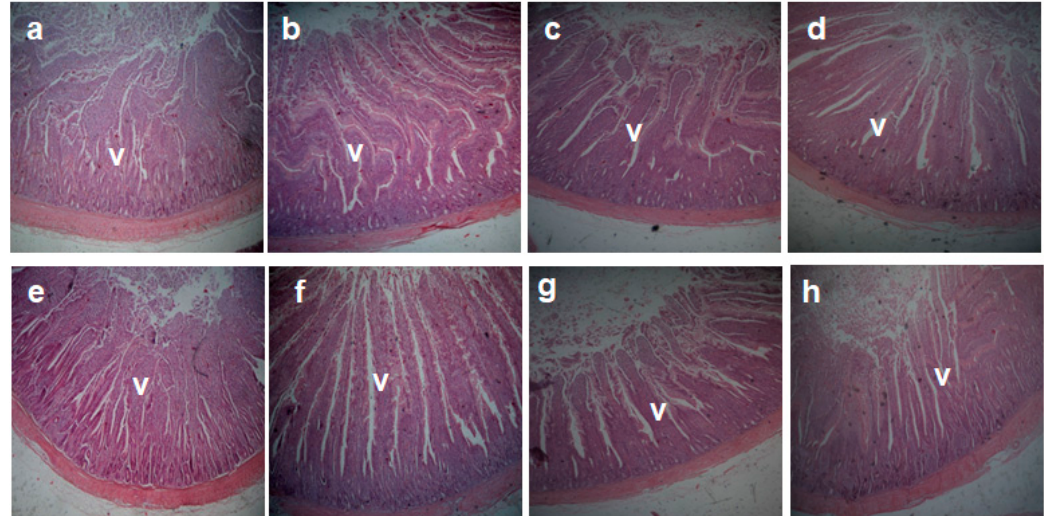
Figure 1. A representative photomicrograph of 40× magnification H&E stained small intestine sections of the broiler chickens. ( a – d ) Duodenal sections from control group, GML1, GML3, and GML5 groups, respectively, showing increase in villus (V) length in GML1, GML3 groups and decrease in the GML5 group. ( e – h ) Jejunal sections from the control group, GML1, GML3, and GML5 groups, respectively, showing increase in villus (V) length in the GML1 group compared to the control group.